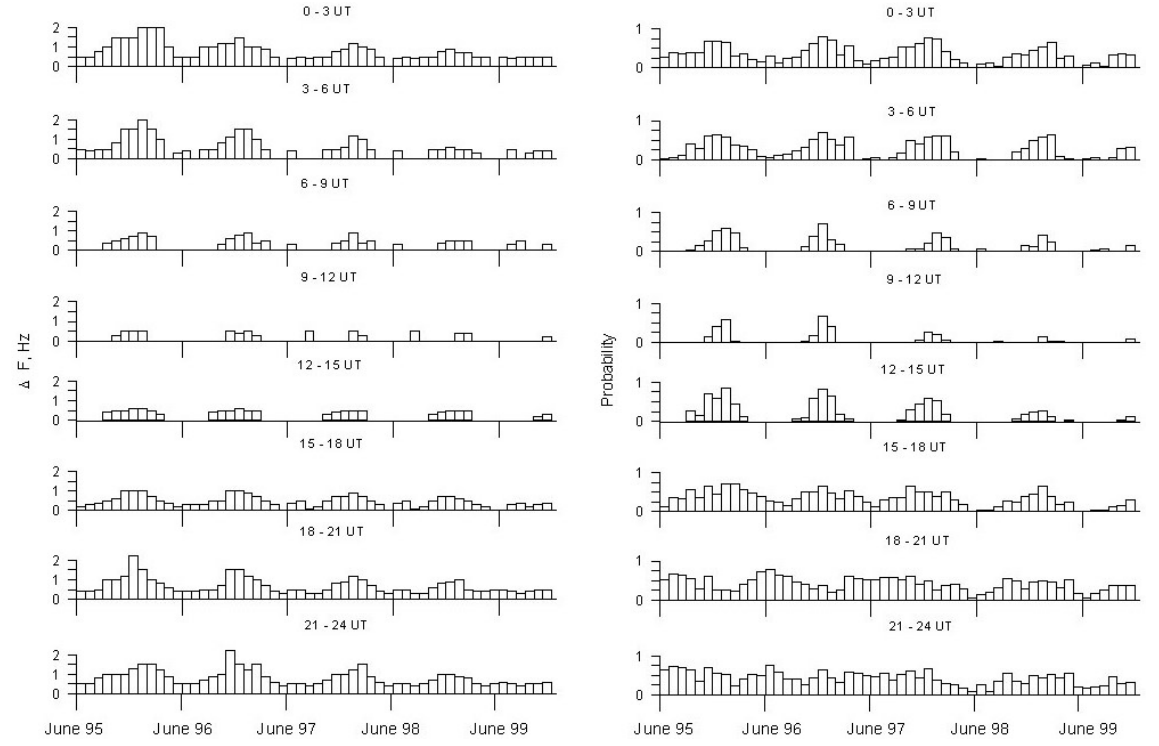
Fig. 2. (a) Monthly median values of SRS frequency scale observed in SGO during 1995–1999. (b) Monthly occurrence rate of SRS observations in SGO during 1995–1999. Each panel corresponds to a 3-h interval of UT. Note that magnetic local time in SGO is UT+2.